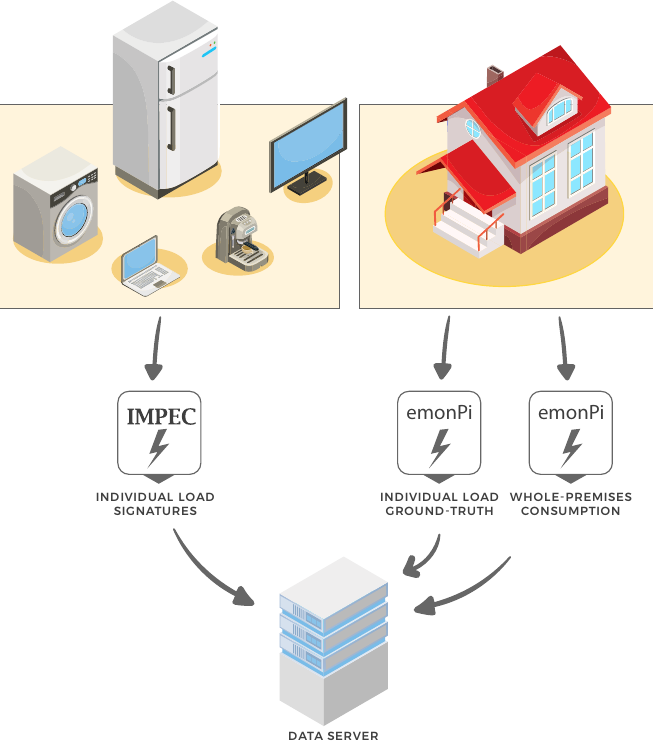
Figure 1. MORED acquisition architecture of whole premises (WP) and individual load (IL) electricity